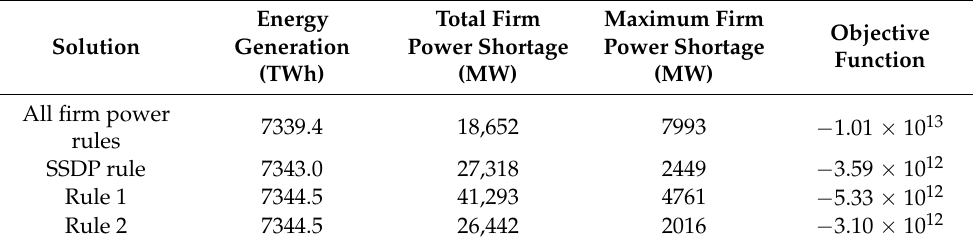
Figure 4. Evolution process using firm power initial solution for all states.